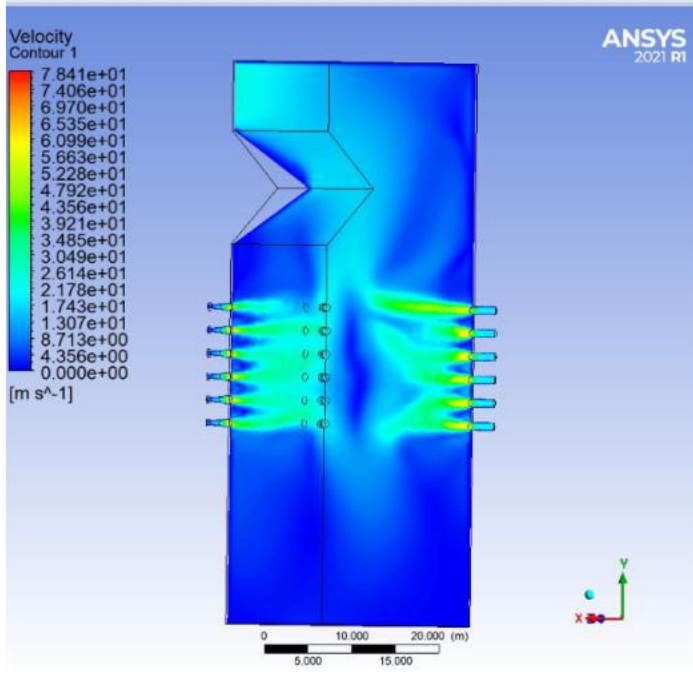
Figure 17. Velocity distribution of flue gas in case-VIII.